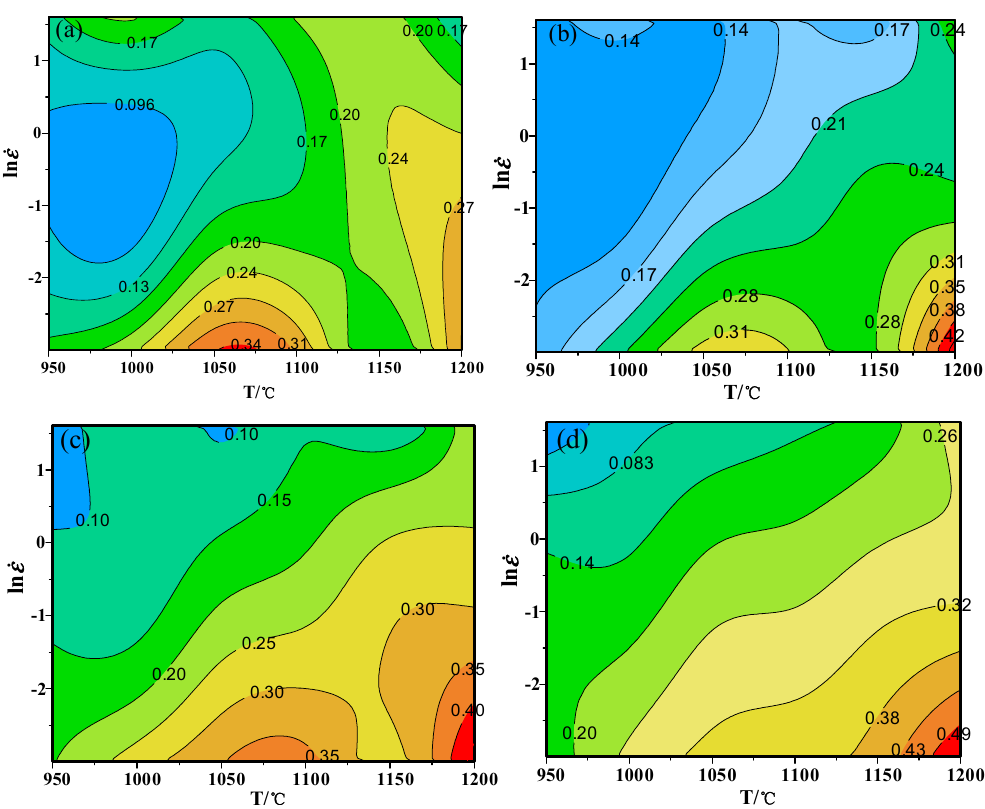
Figure 7. Power dissipation maps at different strains: ( a ) ε = 0.2; ( b ) ε = 0.3; ( c ) ε = 0.4; ( d ) ε = 0.5.